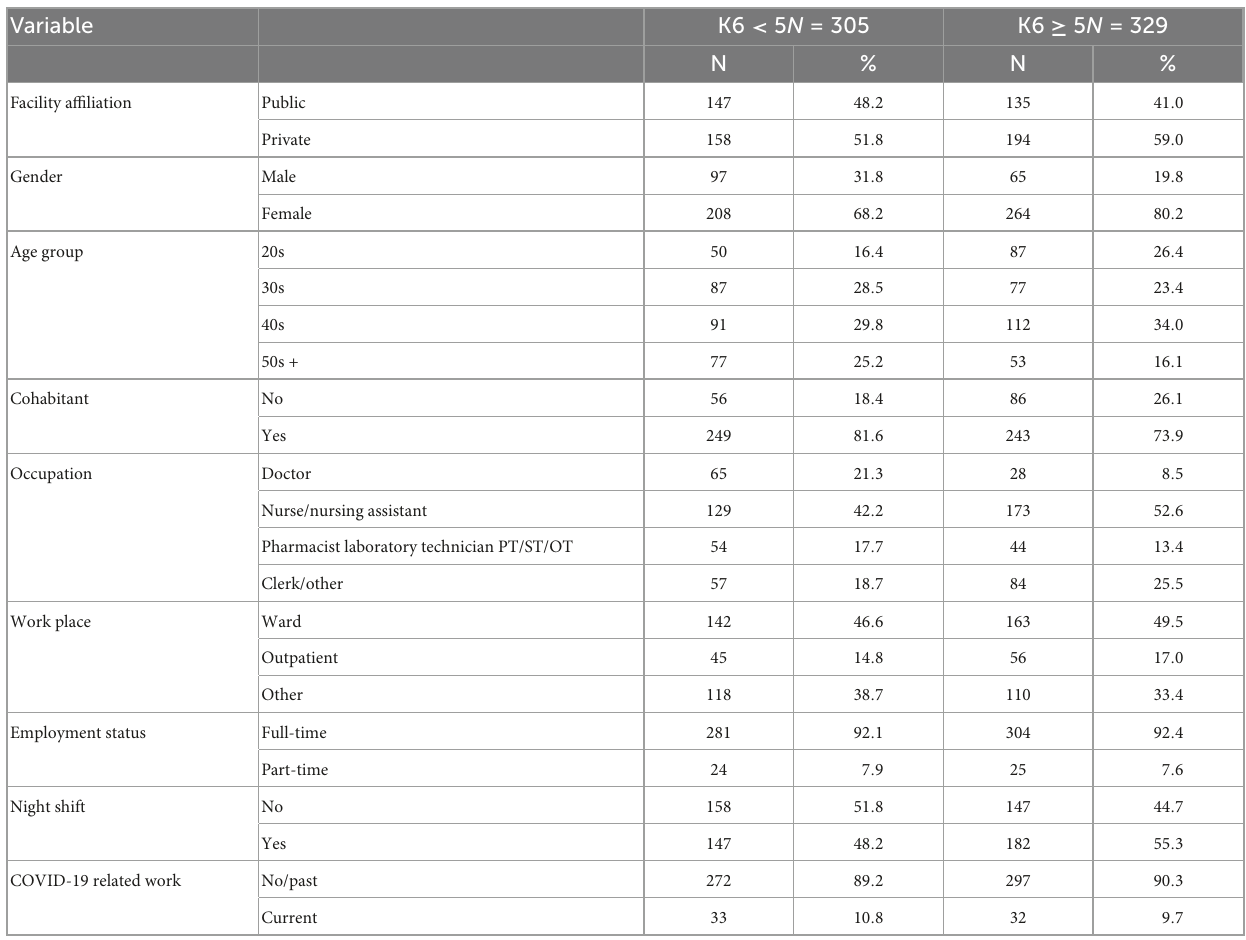
TABLE 1 Characteristics of